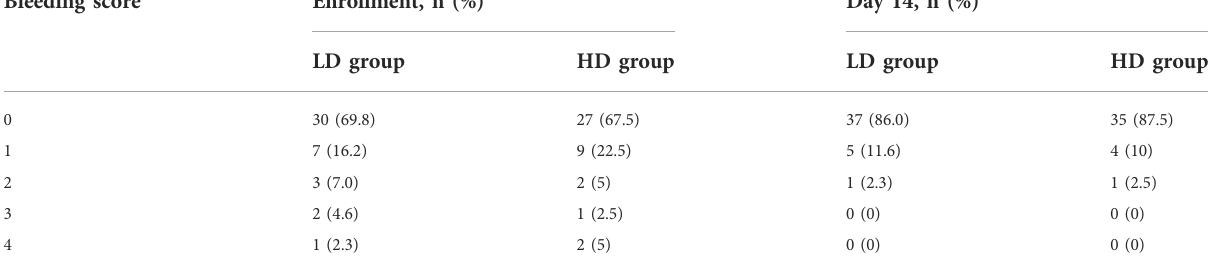
TABLE 2 Bleeding score before and after prednisone